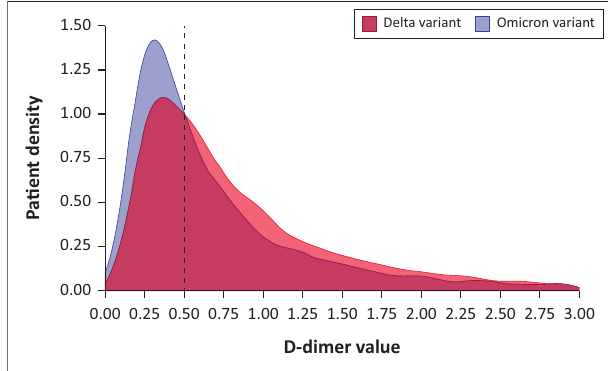
FIGURE 1: Density plot demonstrating the proportion of patients with initial D-dimer values subdivided by the most common variant of COVID-19 isolated at the time of diagnosis. The dotted line indicates the laboratory threshold for an elevated